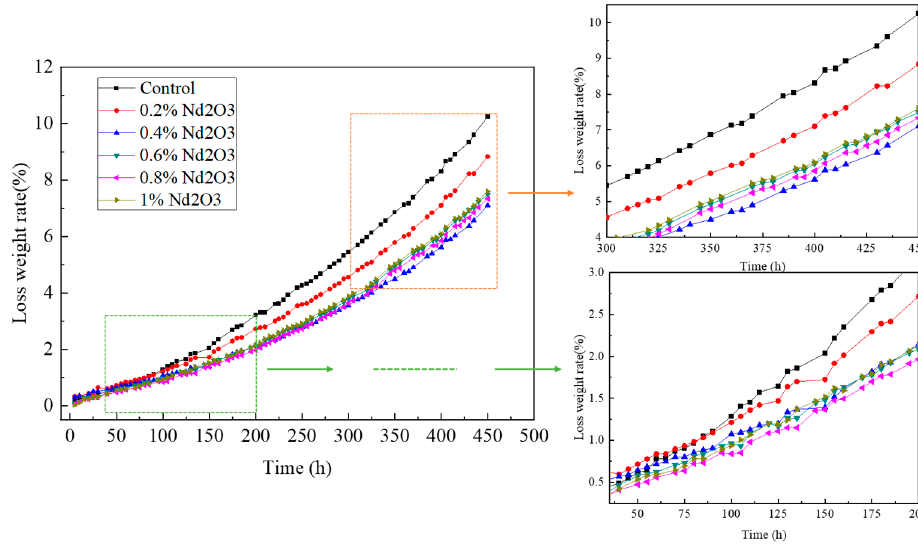
Figure 10. The weight loss rate of the polyimide with different contents of Nd 2 O 3 at 350 °C.